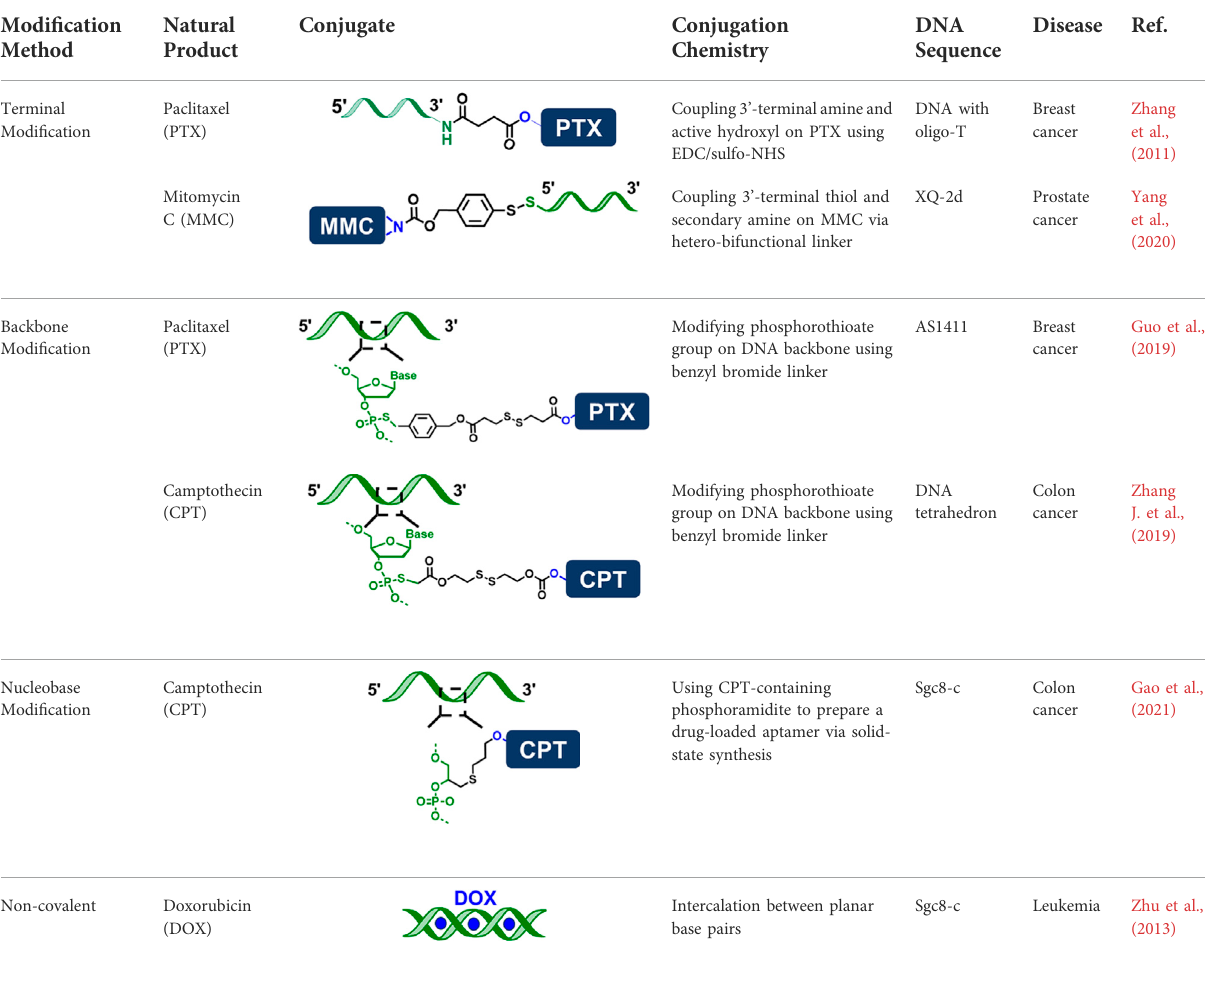
TABLE 1 Representative examples of DNA – natural product